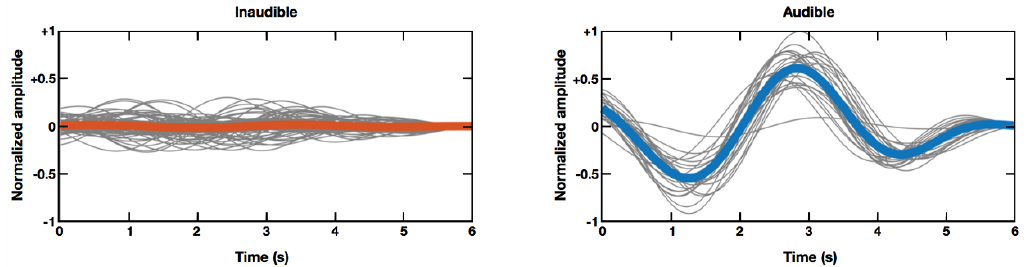
Figure 2. An example of grand averaged (bold) horizontal EOG and single trial EOGs (grey) recorded under different conditions: inaudible condition ( left ) and audible condition ( right ). These signals were recorded from a single participant (participant seven).